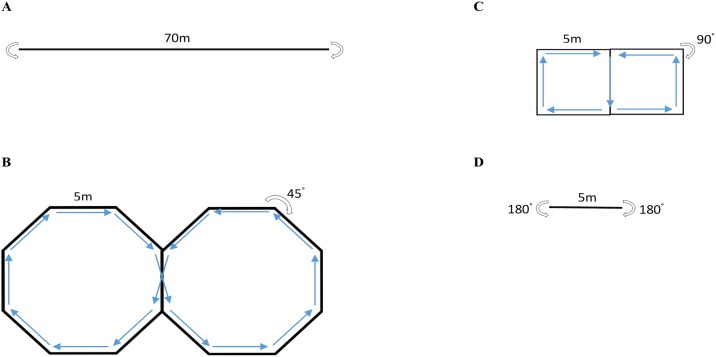
Schematic of the turning protocol showing 5m straights interspersed by prescribed turns of a) 0° b) 45° c) 90° and d) 180° with equal left and right hand turns.